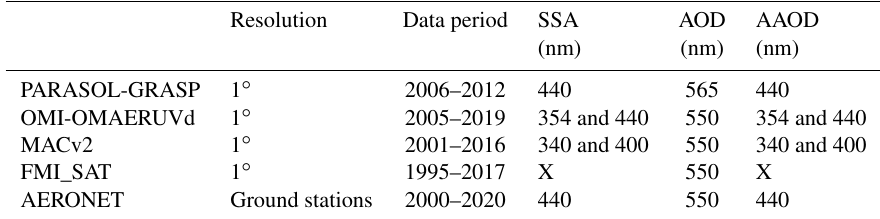
Table 2. Summary of the main characteristics of the reference data sets used in this